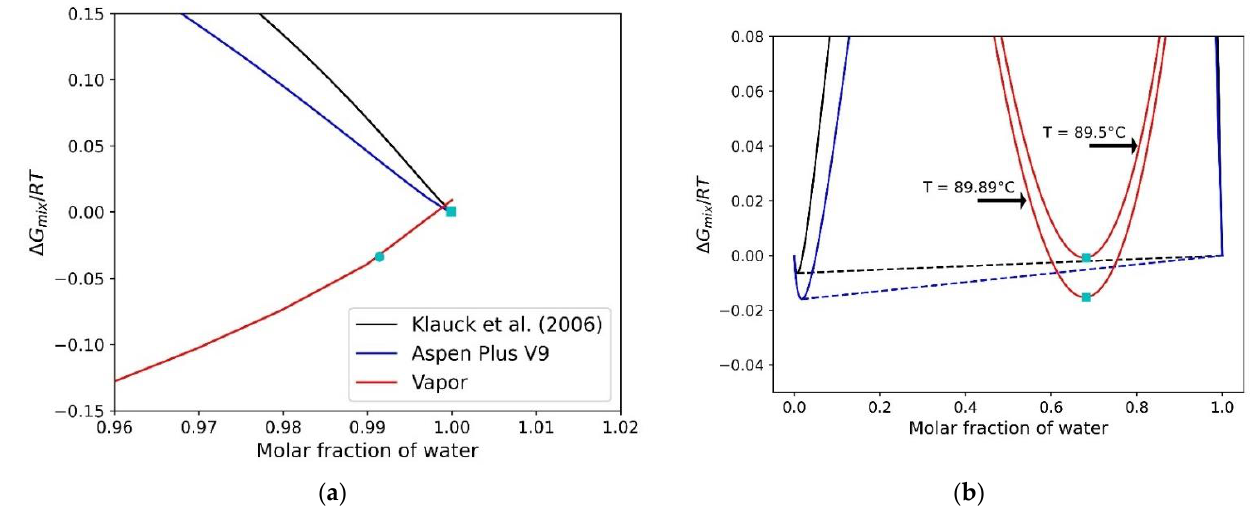
Figure 8. Comparison of the Vapor ∆ G mix with Available Data from the Technical Literature for ( a ) VLE at 99.76 ◦ C and 1 atm and ( b ) VLLE at 89.5 ◦ C and 1 atm. Note: Reported data points are from